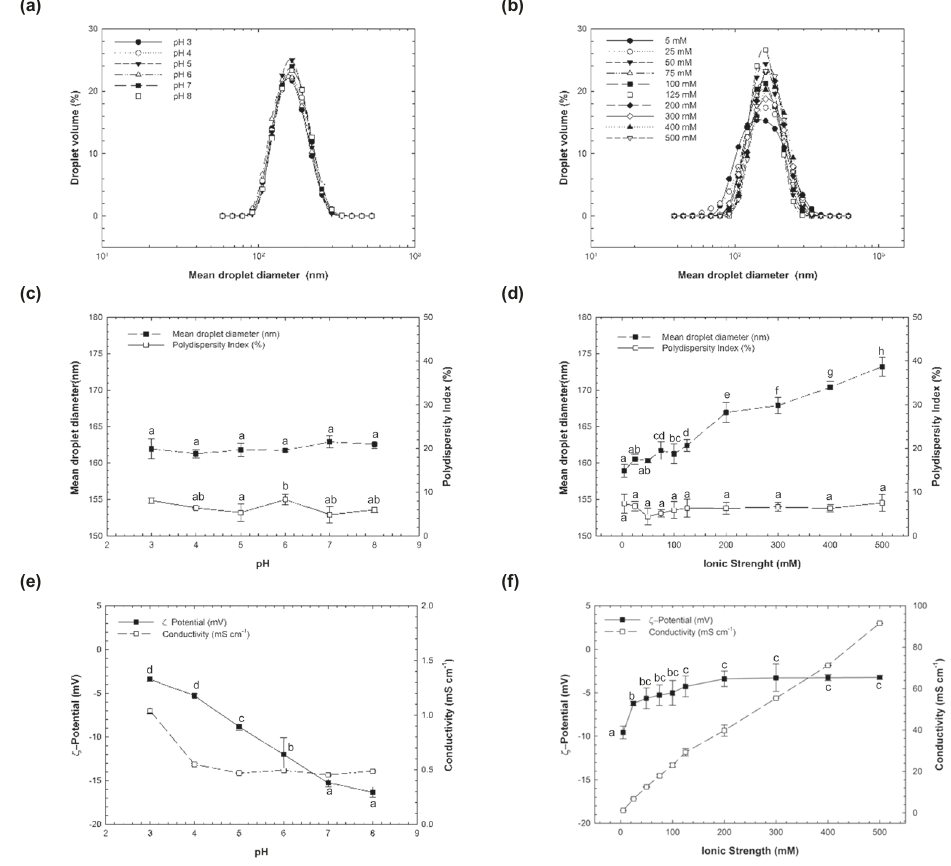
Values (n = 3; mean ± s.d.) accompanied by different lowercase letters indicate significant differences (Duncan Multiple Range Test; p < 0.05). Fig. 3 Solution condition tests applied to the physical-stability studies of 9 α TOH-NE at 25 °C. ( a ) and ( b ) Particle size distribution for pH (3 – 8) and salt concentration assessments; ( c ) and ( d ) Mean droplet diameter and polydispersity index for pH and salt concentration analyses; ( e ) and ( f ) ζ -potential and conductivity found for pH and ionic concentration